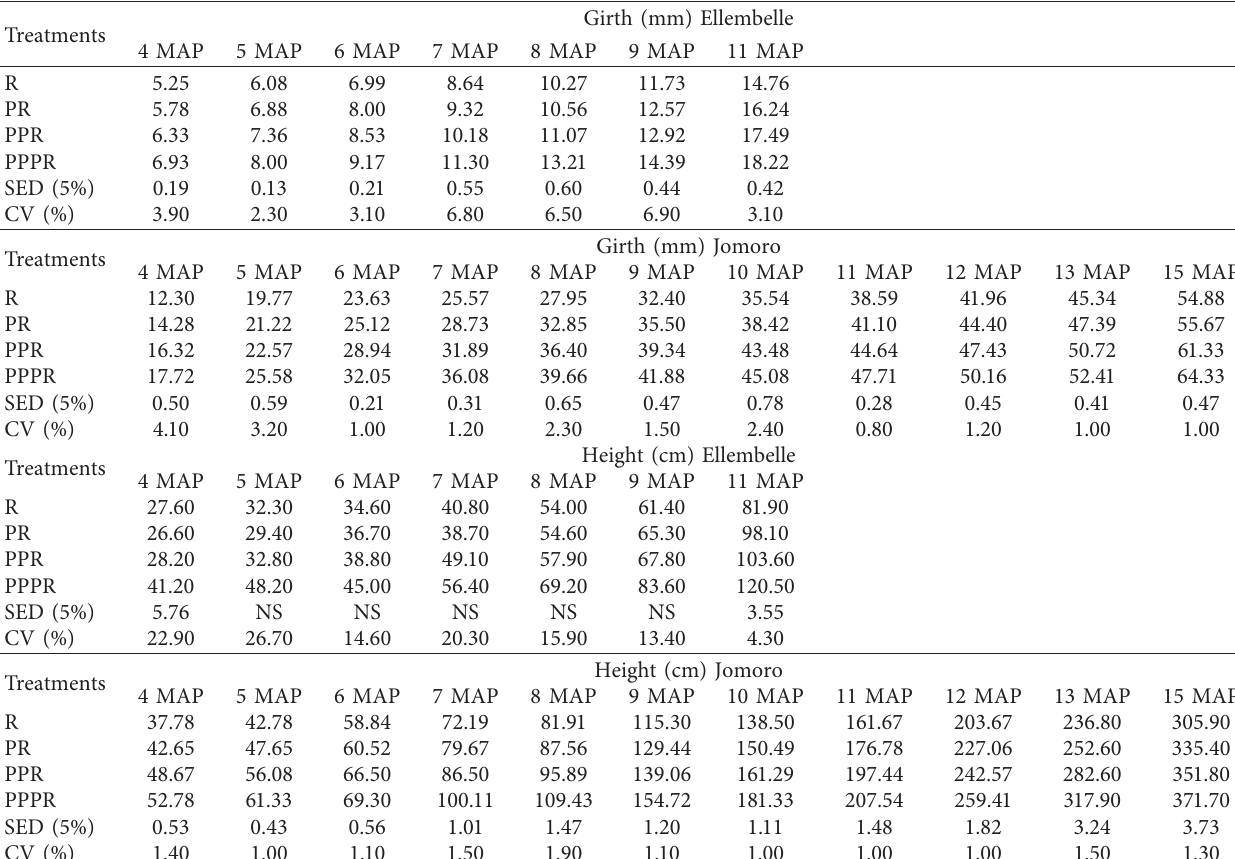
Table 1: Stem girth and height growth of rubber tree at Ellembelle and Jomoro.